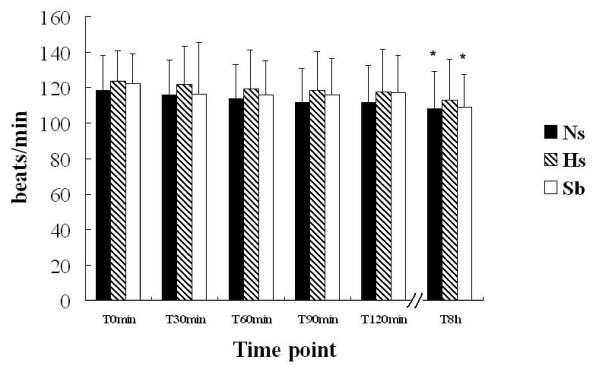
Effects of fluid resuscitation on heart rate in the three groups. Heart rate in all cases was recorded by statisticians. There were no differences in heart rate among the groups during the 120 min trial or the 8 h follow-up. Comparing heart rate in the same group, the heart rate at T8h was lower than that at T0 in the Ns and Sb groups (*p < 0.05), but no change of heart rate appeared in the Hs group. Resuscitation by fluids did not change heart rate in patients during the 120 min trial.